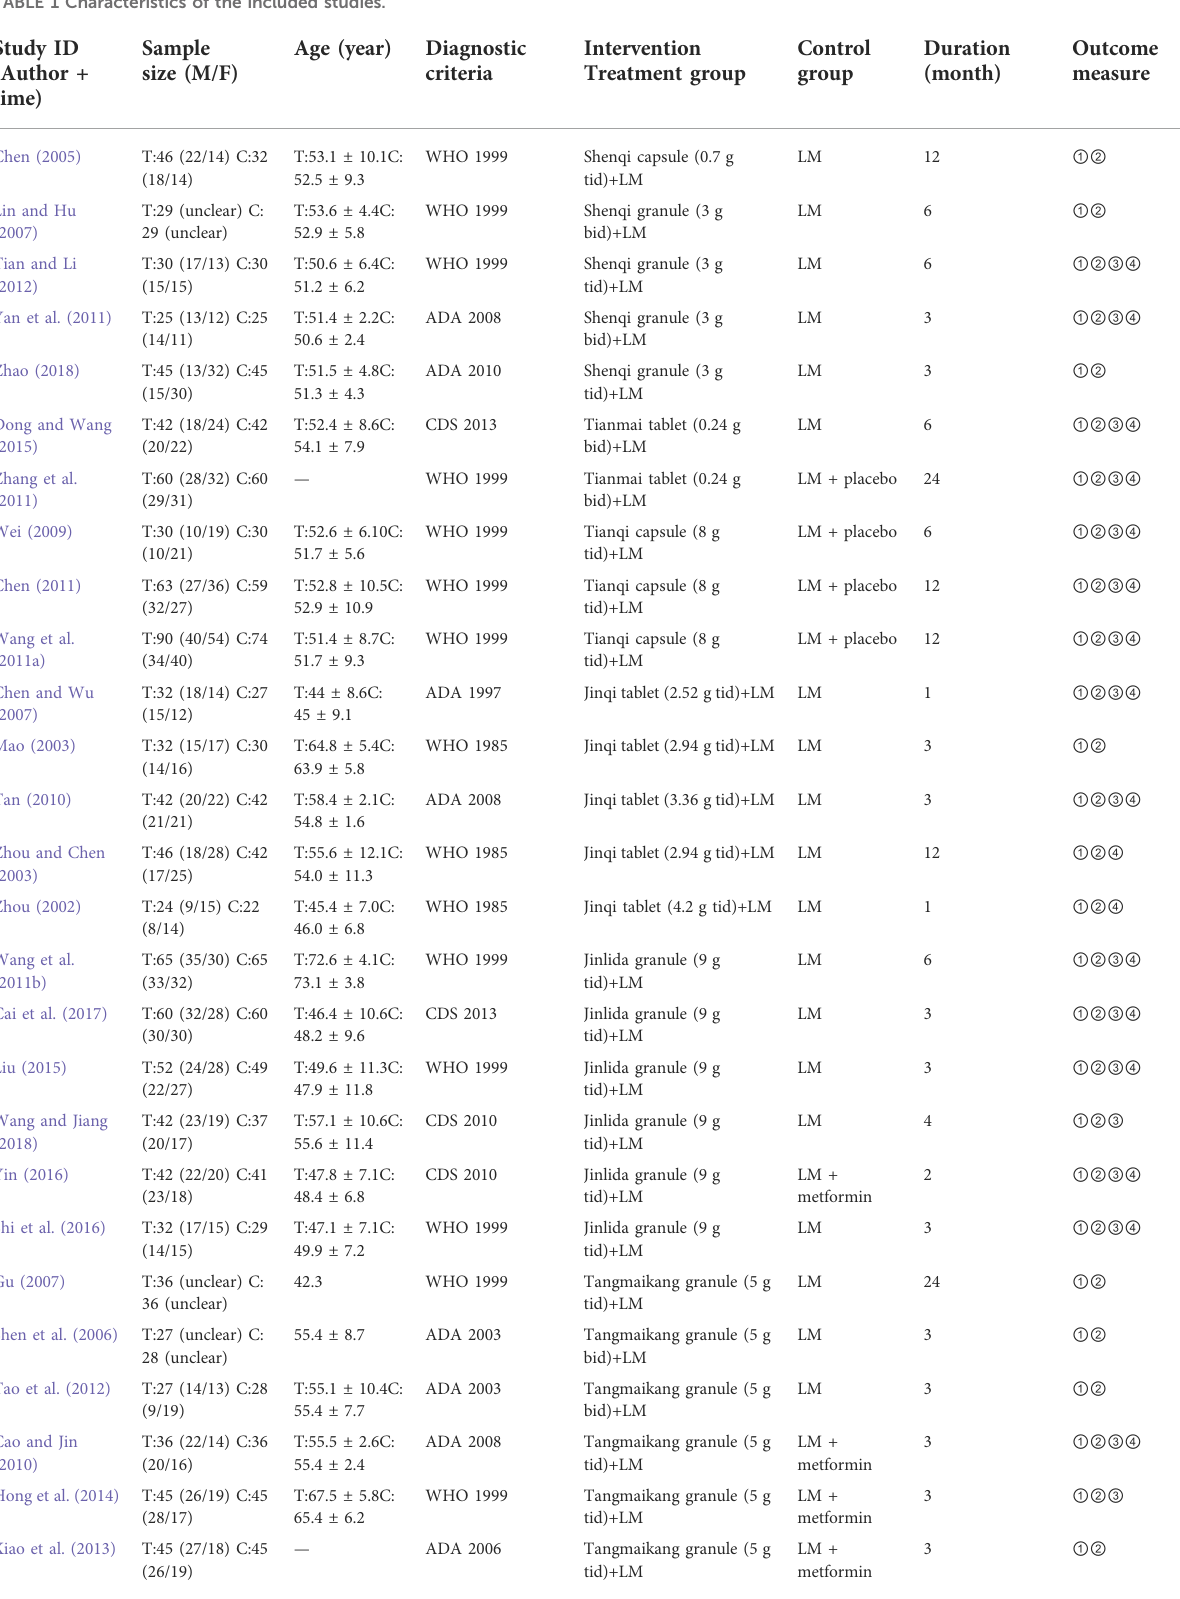
TABLE 1 Characteristics of the included